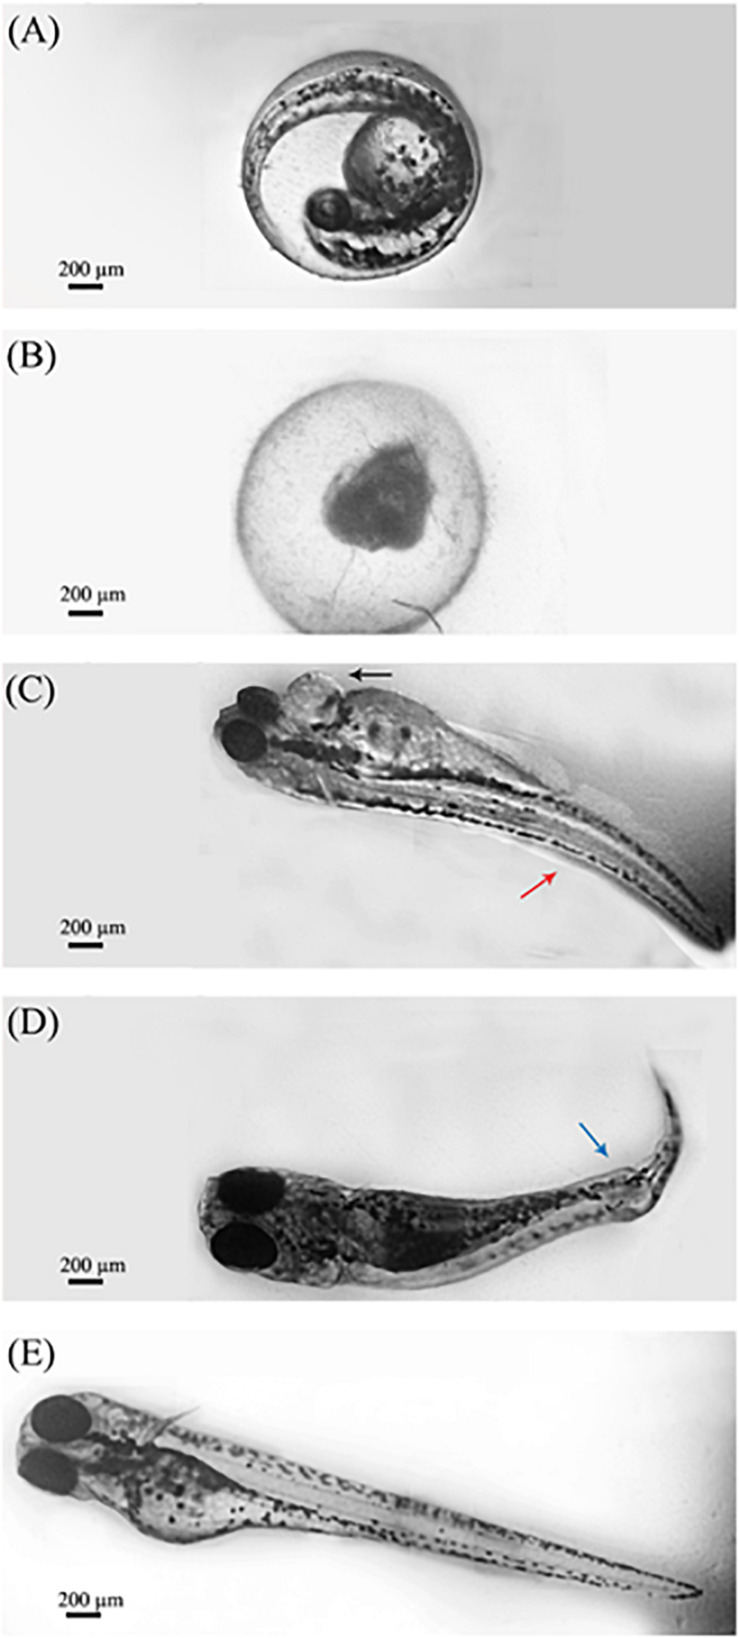
Morphological characteristics of zebrafish larvae after exposure to OligoPKC. Image capture was done through a 4× objective lens. (A) Zebrafish embryo observed at the pharyngula stage (24 hpf) without any OligoPKC treatment and 0 h of exposure. (B) Lethal toxicity of OlicoPKC at 1,000 μg/ml. Larvae at 6 dpf appear unhatched and coagulated after 120 h of exposure; (C) zebrafish larvae at 6 dpf showing pericardial edema (black arrow) and body curvature (red arrow) at 500 μg/ml after 120 h of exposure; (D) zebrafish larvae at 6 dpf showing kinked tail (blue arrow) at 500 μg/ml after 120 h of exposure and; (E) control. Larvae at 6 dpf appears normal and is free of developmental defects. Image processing using Adobe Photoshop CS3 have been applied in order to group several snapshots of the same larvae into one cohesive image and to reduce the background noise of the images in question. The changes made to the images does not alter the intended information shown in the figure. Scale bar = 200 μm.